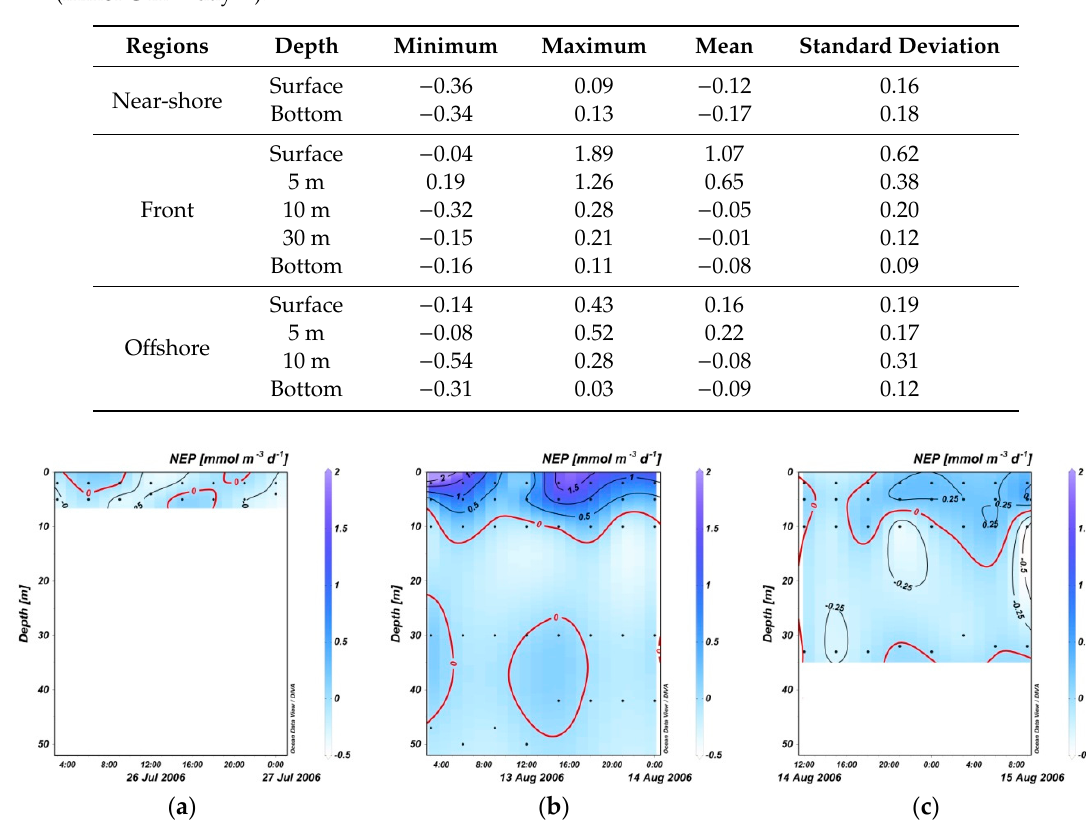
Figure 5. Twenty-four-hour variation in NEP in the near-shore ( a ), front ( b ), and offshore ( c ) regions in summer.